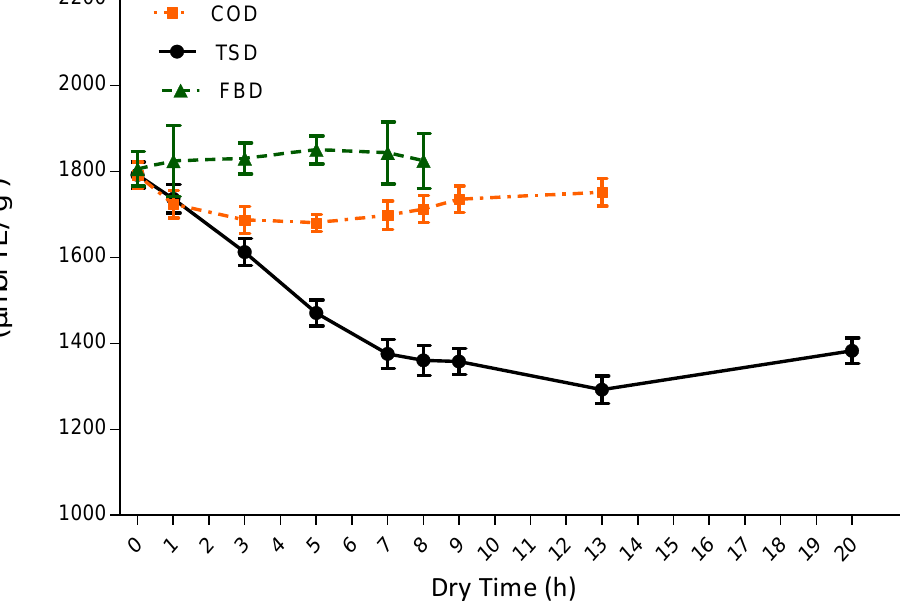
Figure 2. Effect drying treatments in curcuma longa rhizomes. Variation of antioxidant capacity (ORAC) of rhizomes during TSD, COD, and FBD.